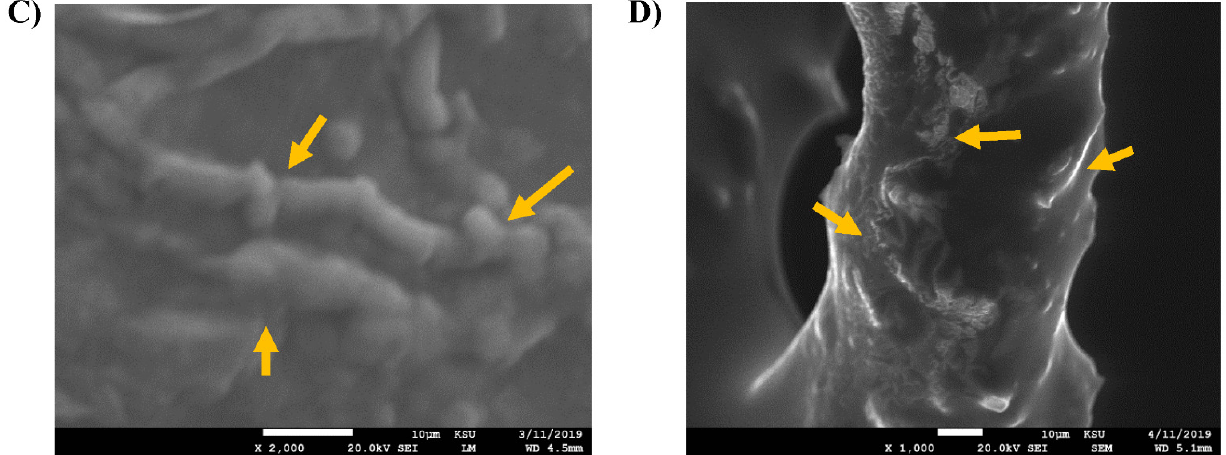
Figure 5. SEM images of F. proliferatum. The tested slides were loaded with F. proliferatum upon treatment with 1% crude oil. ( A ) (At 800 × , scale bar 10 µ m) and ( B ) (At 1000 × , scale bar 10 µ m) normal morphology of the healthy control, ( C ) (At 2000 × , scale bar 10 µ m), and ( D ) (At 1000 × , scale bar 10 μ m) showed abnormal configuration of the fungus treated with 1% crude oil, indicated by the yellow arrows, ( C , D ) showing the swelling of edges.